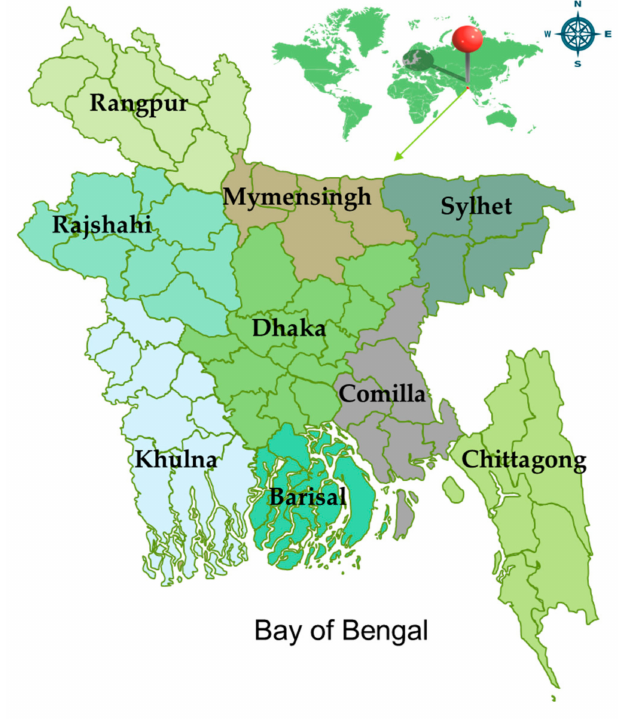
Figure 1. Map of the objective regions of